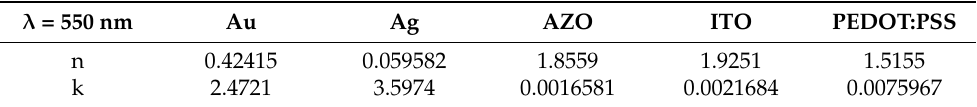
Table 1. Values for the real part, n, and imaginary part, k, of the refractive index of the materials composing the core–shell particles (corresponding to the electromagnetic radiation wavelength λ = 550 nm) and used for the calculations [50]. λ = 550 nm Au Ag AZO ITO